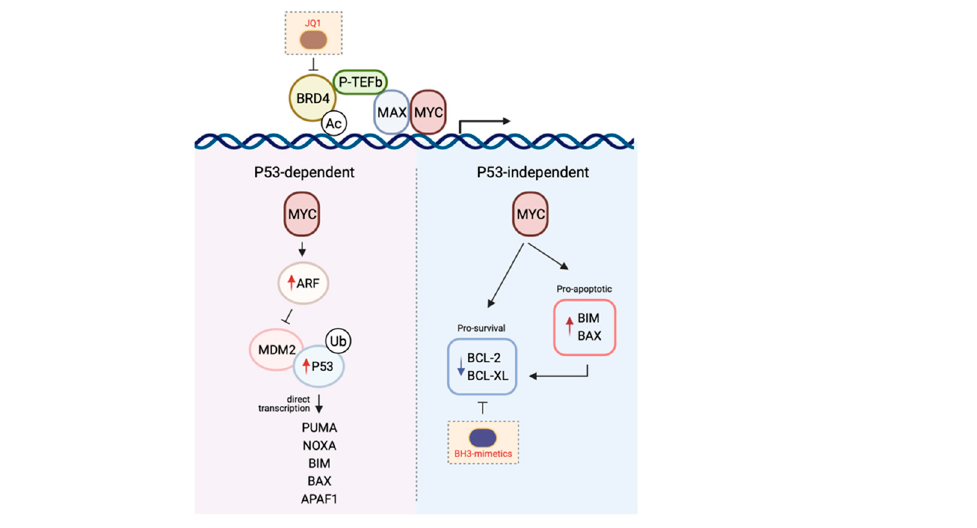
Figure 2. The mechanisms by which MYC induces apoptosis. The P53-dependent pathway to MYC-induced death is primarily mediated by the ARF-MDM-P53 axis following the upregulation of ARF expression by MYC. This leads to the stabilisation of P53 and the induction of P53 pro-apoptotic target genes. In contrast, the P53-independent pathway to MYC-induced apoptosis is reliant on the direct transcription of pro-apoptotic genes or the repression of pro-survival protein expression. Given the cooperativity between MYC signalling and the BCL-2-regulated apoptotic pathway in promoting tumourigenesis, combining drugs targeting both arms (e.g., MYC with JQ1, BCL-2 pro-survival proteins with BH3-mimetics) is a promising therapeutic avenue (see Section 5). Figure created with Biorender.com.